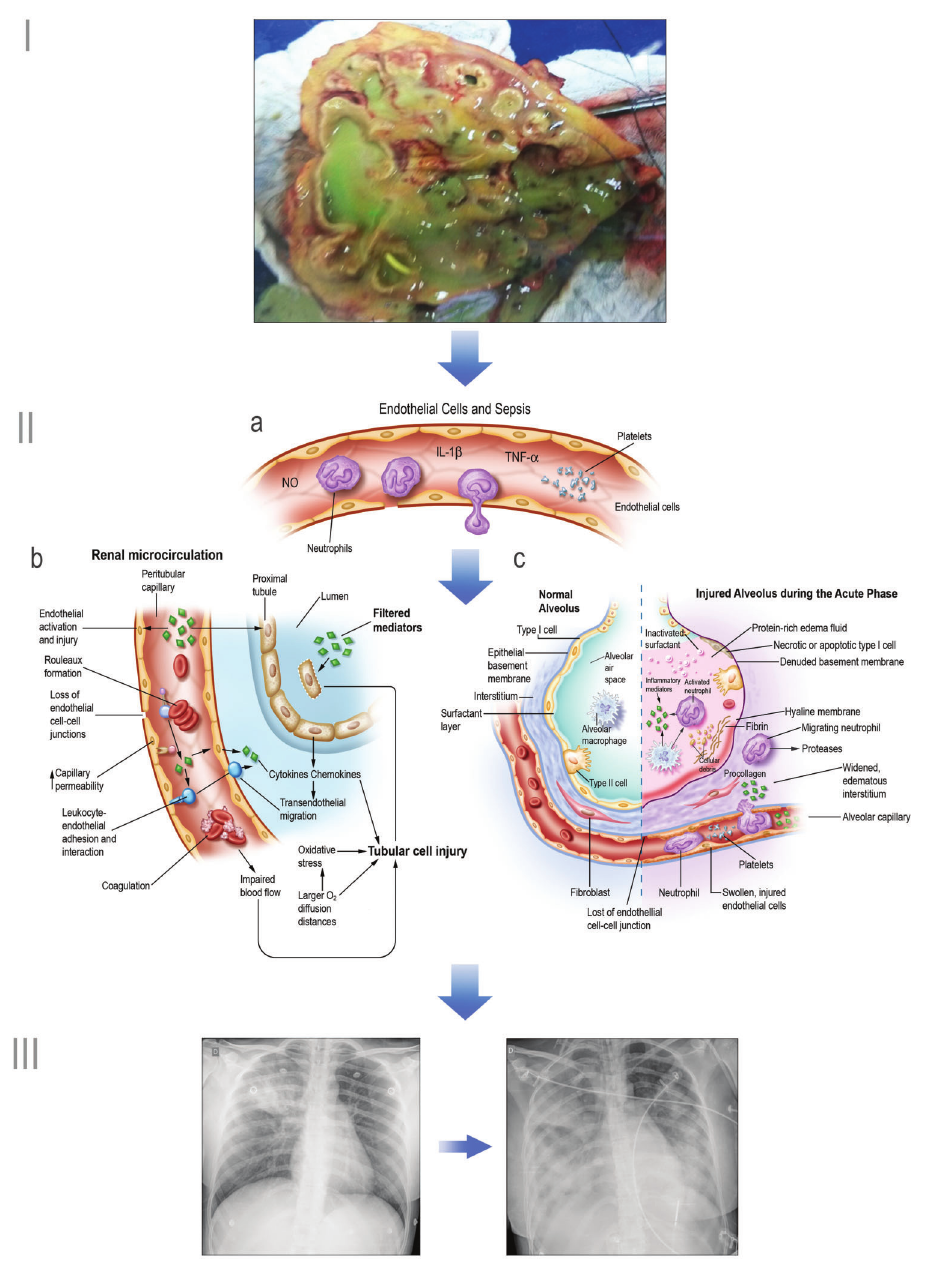
Figure 1. Sequential steps of sepsis pathogenesis and organ dysfunction. I , Infection: pyelonephritis in a patient with septic shock. II, Sepsis-induced endothelial changes leading to organ dysfunction; IIa , Schematic endothelial changes; IIb , Renal microcirculation: sepsis-induced injury to the endothelium, microcirculation and tubular cells. Adapted with permission from Springer-Nature (89) Copyright 2018; IIc, Alveolus-capillary changes during the acute phase of acute lung injury and acute respiratory distress syndrome. From (90) Copyright 2000. Reprinted with permission from Massachusetts Medical Society. III , Organ dysfunction: radiographic fi ndings in a septic patient with progressive lung injury and acute respiratory distress syndrome.